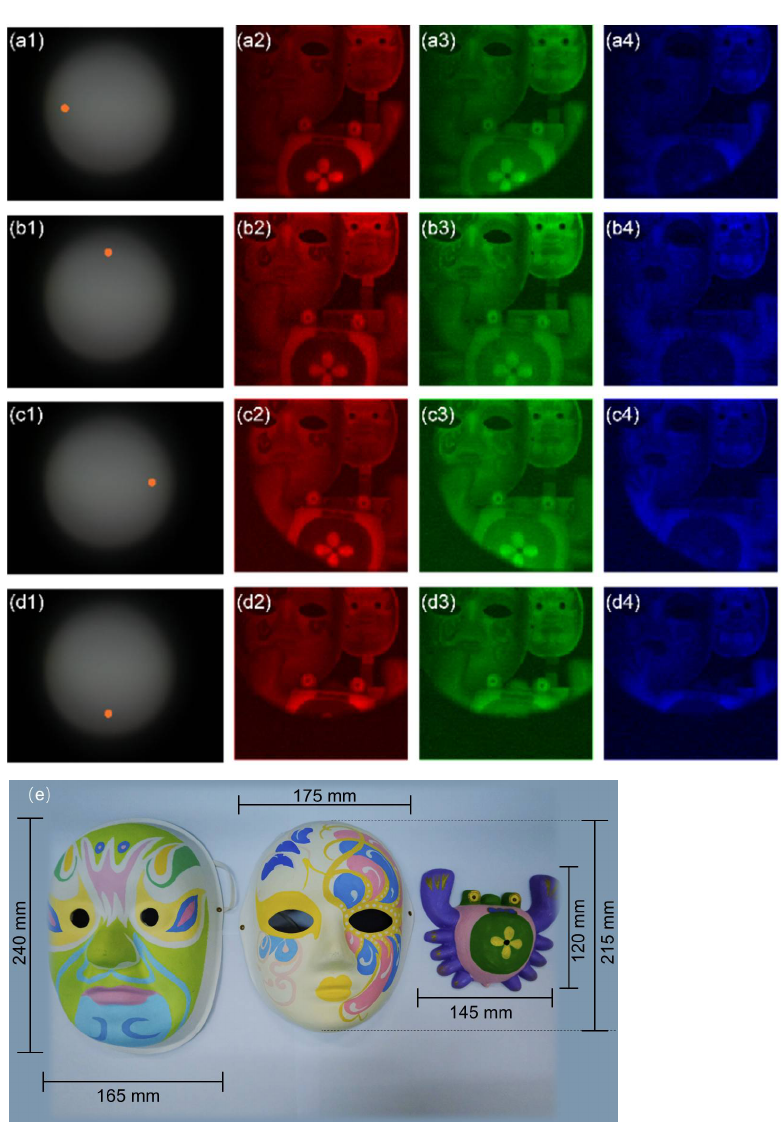
Figure 6. ( a1 – d1 ) The positions of single-pixel detectors (orange dots); ( a2 – a4 ) the perspective images reconstructed by the leftmost single-pixel detector; ( b2 – b4 ) the perspective images reconstructed by the topmost single-pixel detector; ( c2 – c4 ) the perspective images reconstructed by the rightmost single-pixel detector; ( d2 – d4 ) the perspective images reconstructed by the bottommost single-pixel detector (see Visualization 1); ( e ) the physical size of the masks.